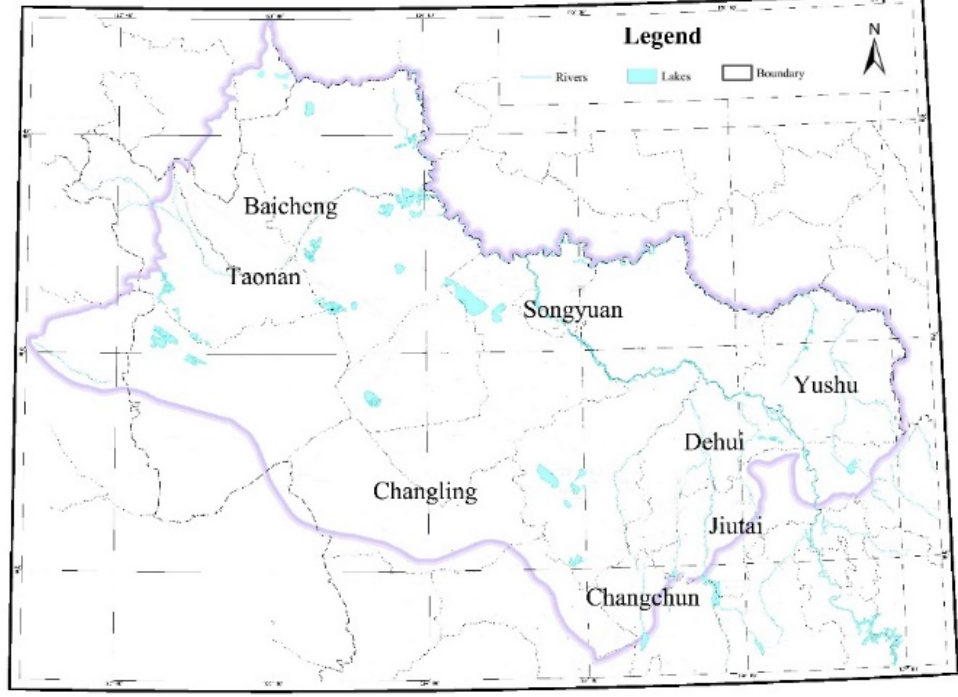
Figure 1. Study area